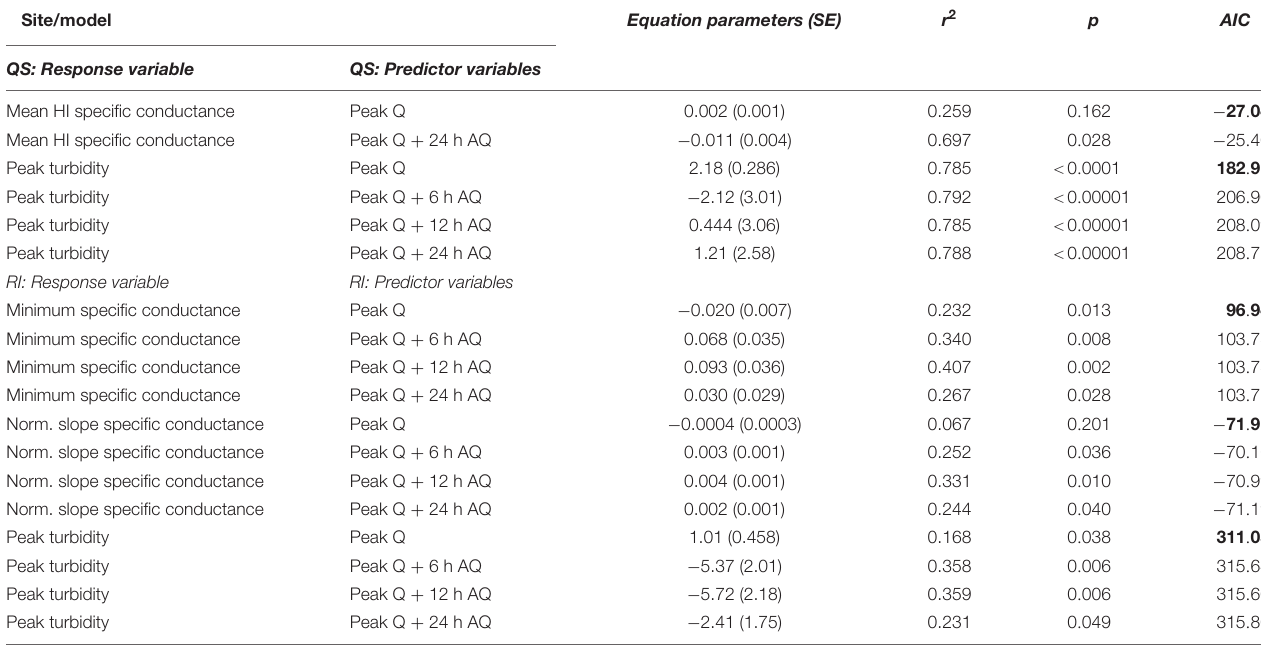
TABLE 3 | Simple and multiple linear regression results of storm and hysteresis metrics with peak and antecedent discharge (AQ) averaged over 6, 12, and 24 h at Quebrada Sonadora (QS) and Rio Icacos (RI). Site/model Equation parameters (SE) r 2 p